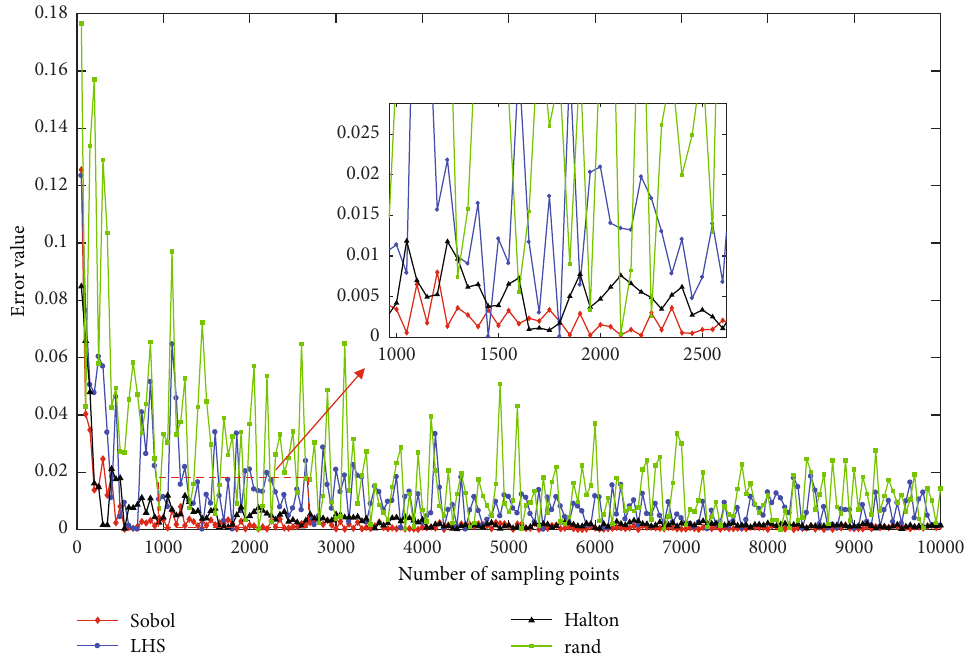
Figure 4: E ff ect of di ff erent sampling methods on the results of global sensitivity analysis. Table 1: Orbital elements of Earth-Moon transfer orbit.